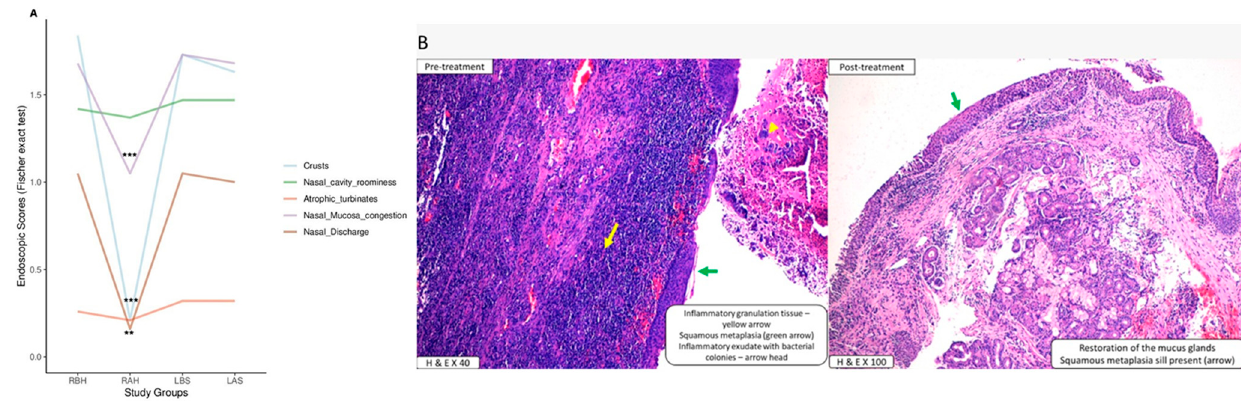
Figure 2. ( A ) Endoscopic scores pre- and post-treatment compared in the right (test) and left (control) sides. ( B ) Restoration of mucosal thickening: the pre- and post-treatment histopathological slide photos showed a decrease in inflammation with a restoration of mucus glands on the right side.